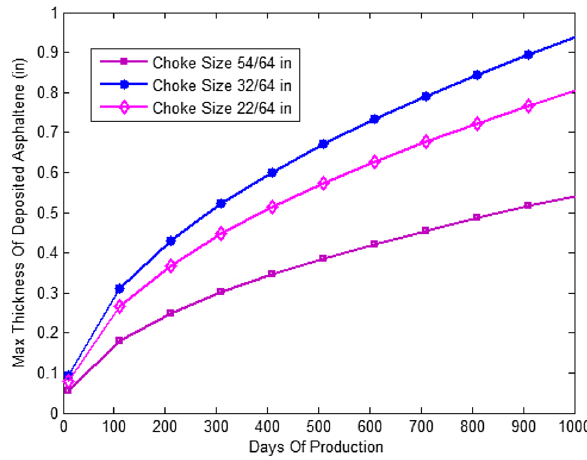
Fig. 19 Sensitivity analysis; effect of tubing size on precipitation pro- file Table 13 Effect of different choke sizes on production rate, pressure and temperature